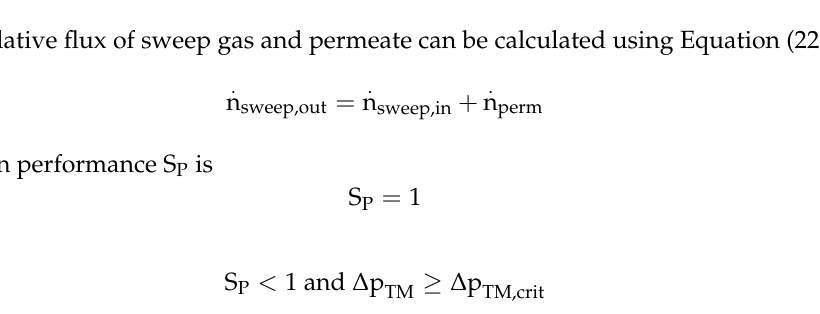
Figure 4. Mass balance model of the separation process.